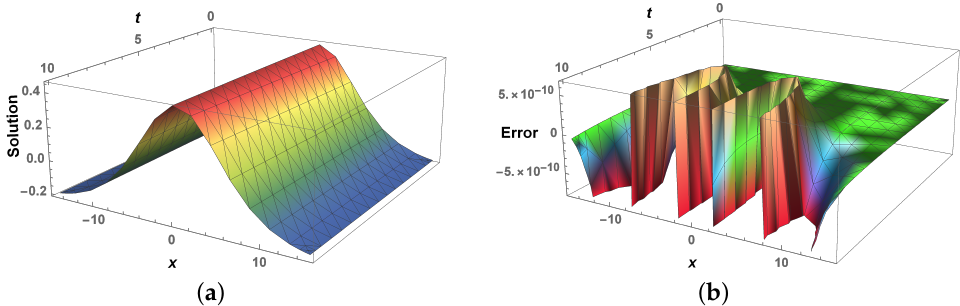
Figure 7. 3D graphical illustration of LHPM solution ( a ) and error ( b ) in Example 2 when β = 1 and k = 0.15.